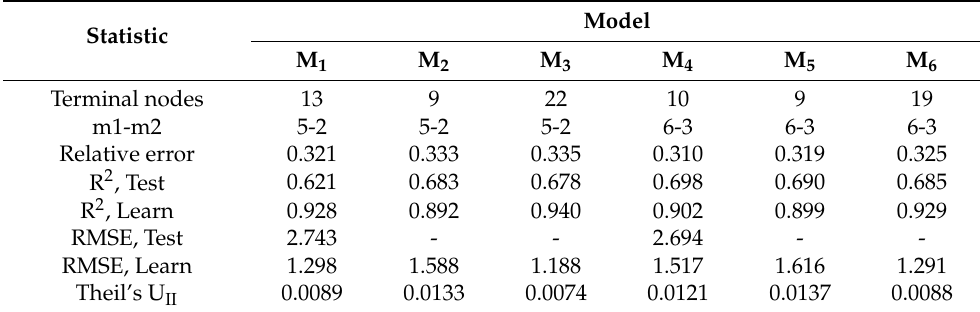
Table 3. Summary statistics of the selected regression CART models for assessment of students’ achievements.